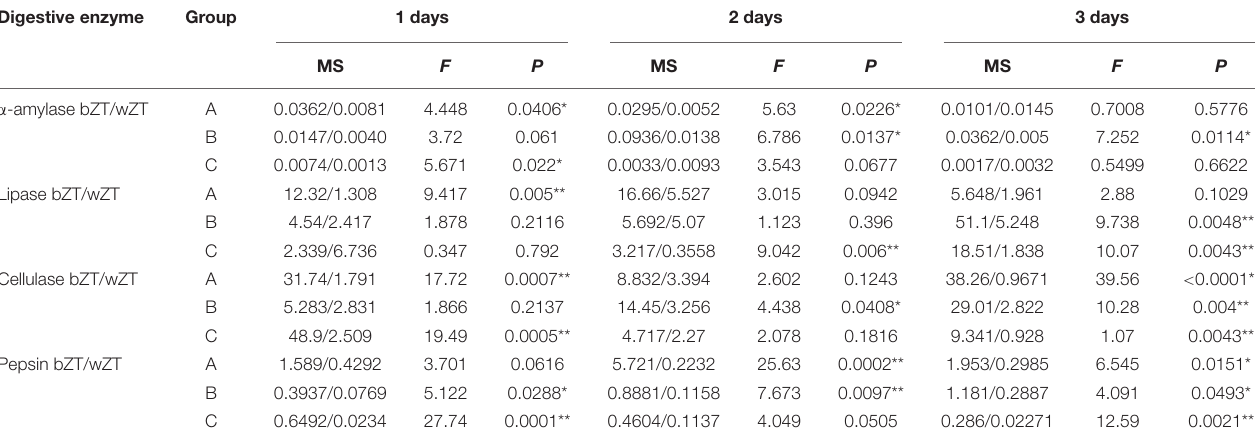
TABLE 3 | Results of one-way ANOVA analysis of digestive enzyme activity under the diurnal cycle. Digestive enzyme Group